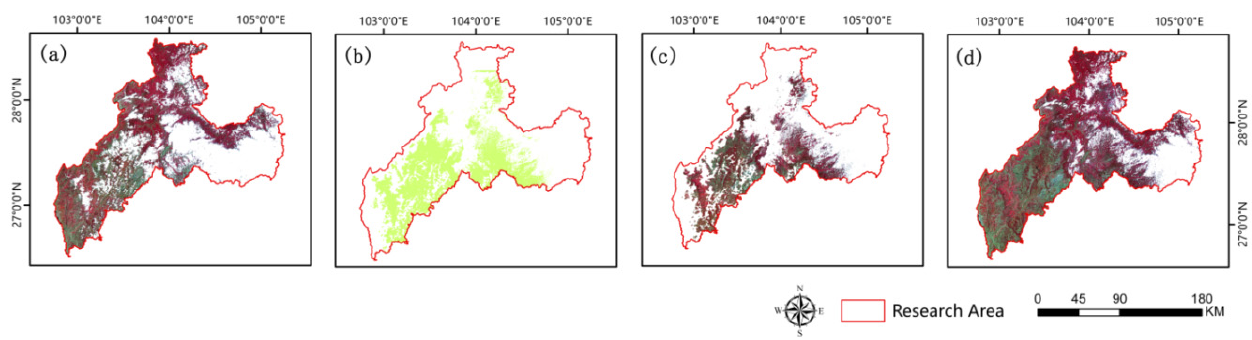
Figure 8. Time-consistent image composite for April 2021: ( a ) Benchmark image; ( b ) vector data; ( c ) correction image; ( d ) time-consistent image, synthesized from ( a , c